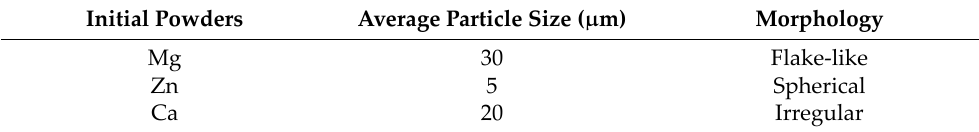
Table 1. Initial powder size and morphology.